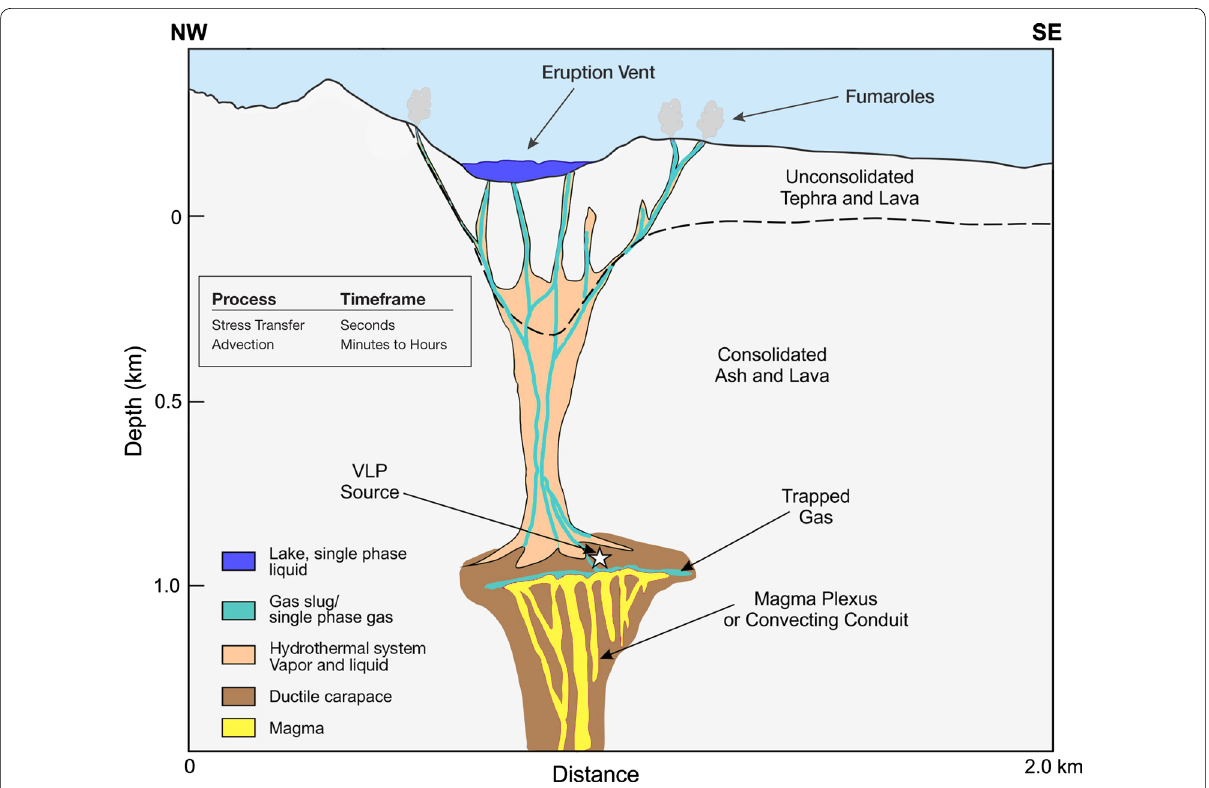
Fig. 11 Cartoon depicting the inferred volcanic conduit system at White Island. Magma is thought to reside at a depth of approximately 1 km depth and provides the source of gas and heat to the shallow hydrothermal system. These are transferred to the surface as a single-phase gas (aquamarine), a two-phase vapor and liquid (tan) and single-phase liquid (blue). The region surrounding the VLP source comprises a ductile low permeability zone (brown) which may intermittently rupture causing high gas discharge and VLP activity. The inset box depicts two potential mechanisms whereby subsurface activity from VLP might be linked to surface activity. Stress transfer might occur almost instantaneously, while mass advection from depth is inherently slower and is dependent on the balance of mass driving and resisting